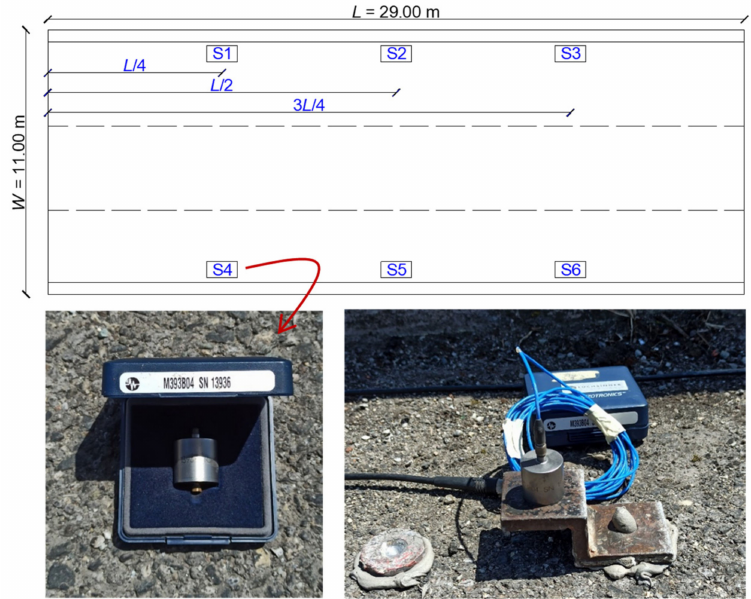
Figure 4. Position of the six accelerometers (S1–S6) on the bridge deck ( top ) and representative accelerometer photograph ( bottom